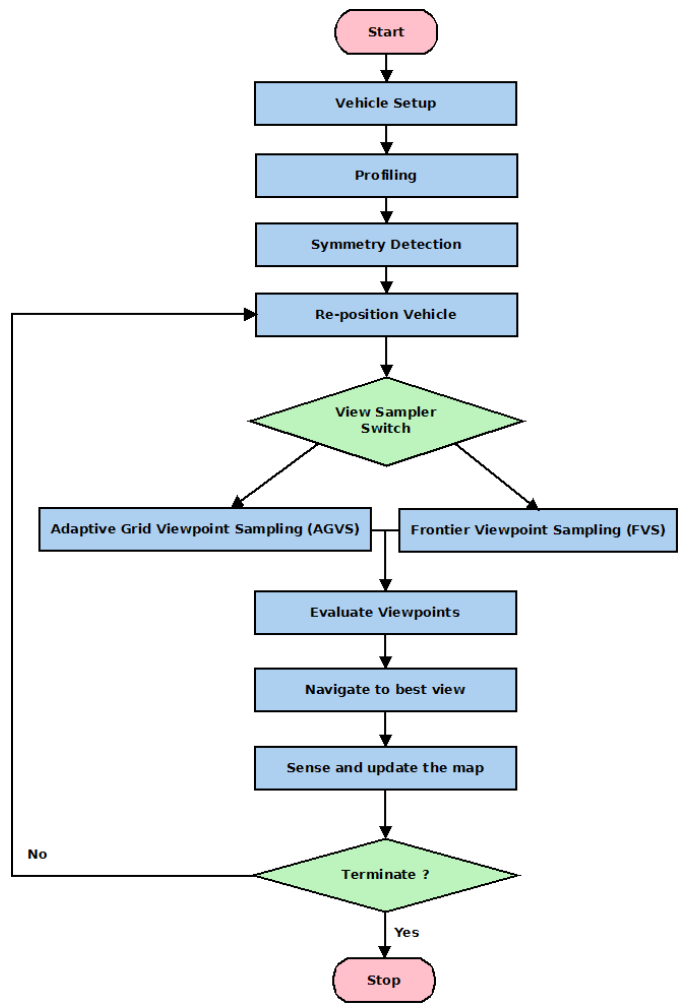
Figure 1. A flowchart of the proposed Guided Next Best View (NBV)